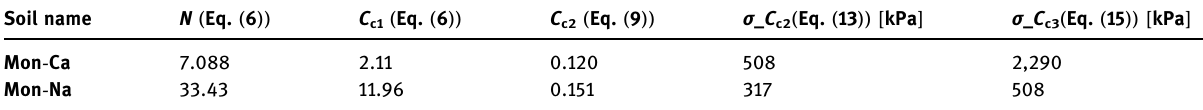
Table 4: Calculated parameters of NCL equation for Mon - Ca and Mon - Na using the proposed equations in this study with LL > 110% Soil